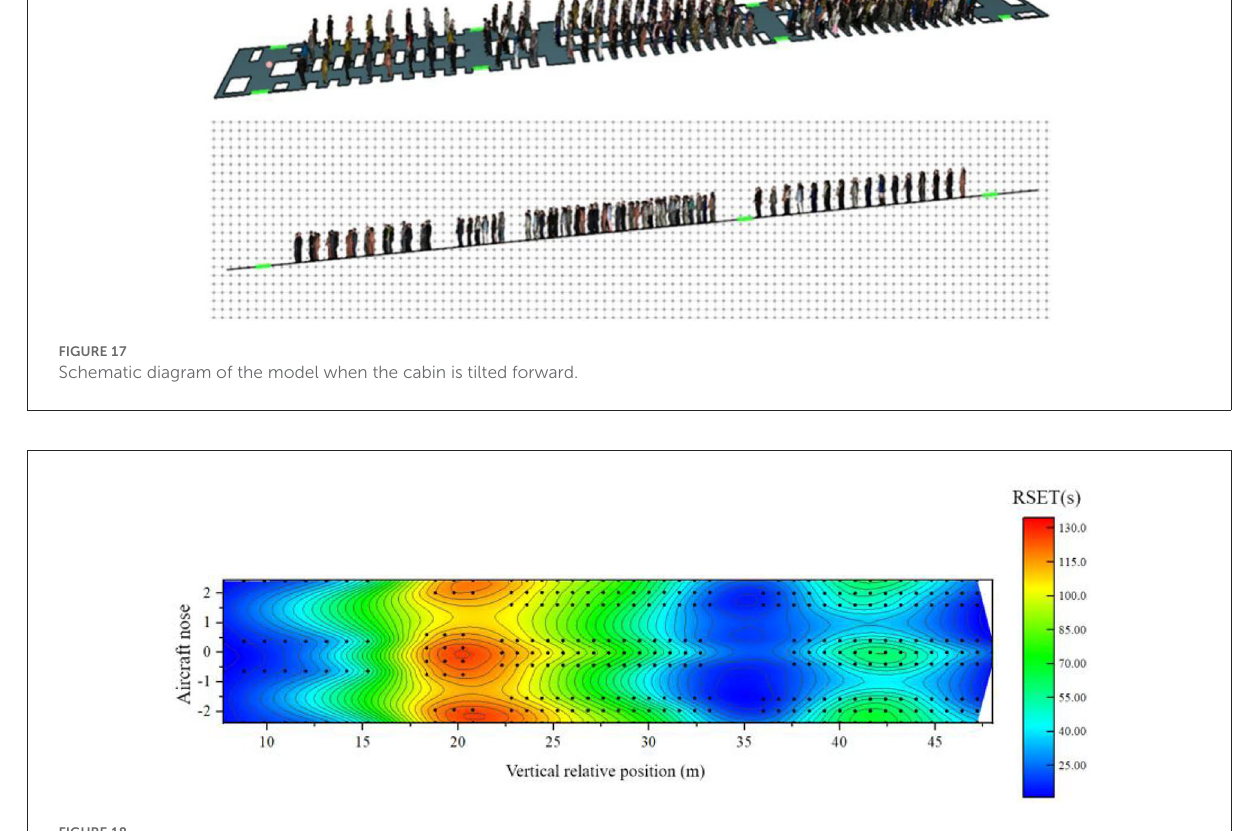
passenger is away from the danger brought by the fire, and the smaller the risk (27,